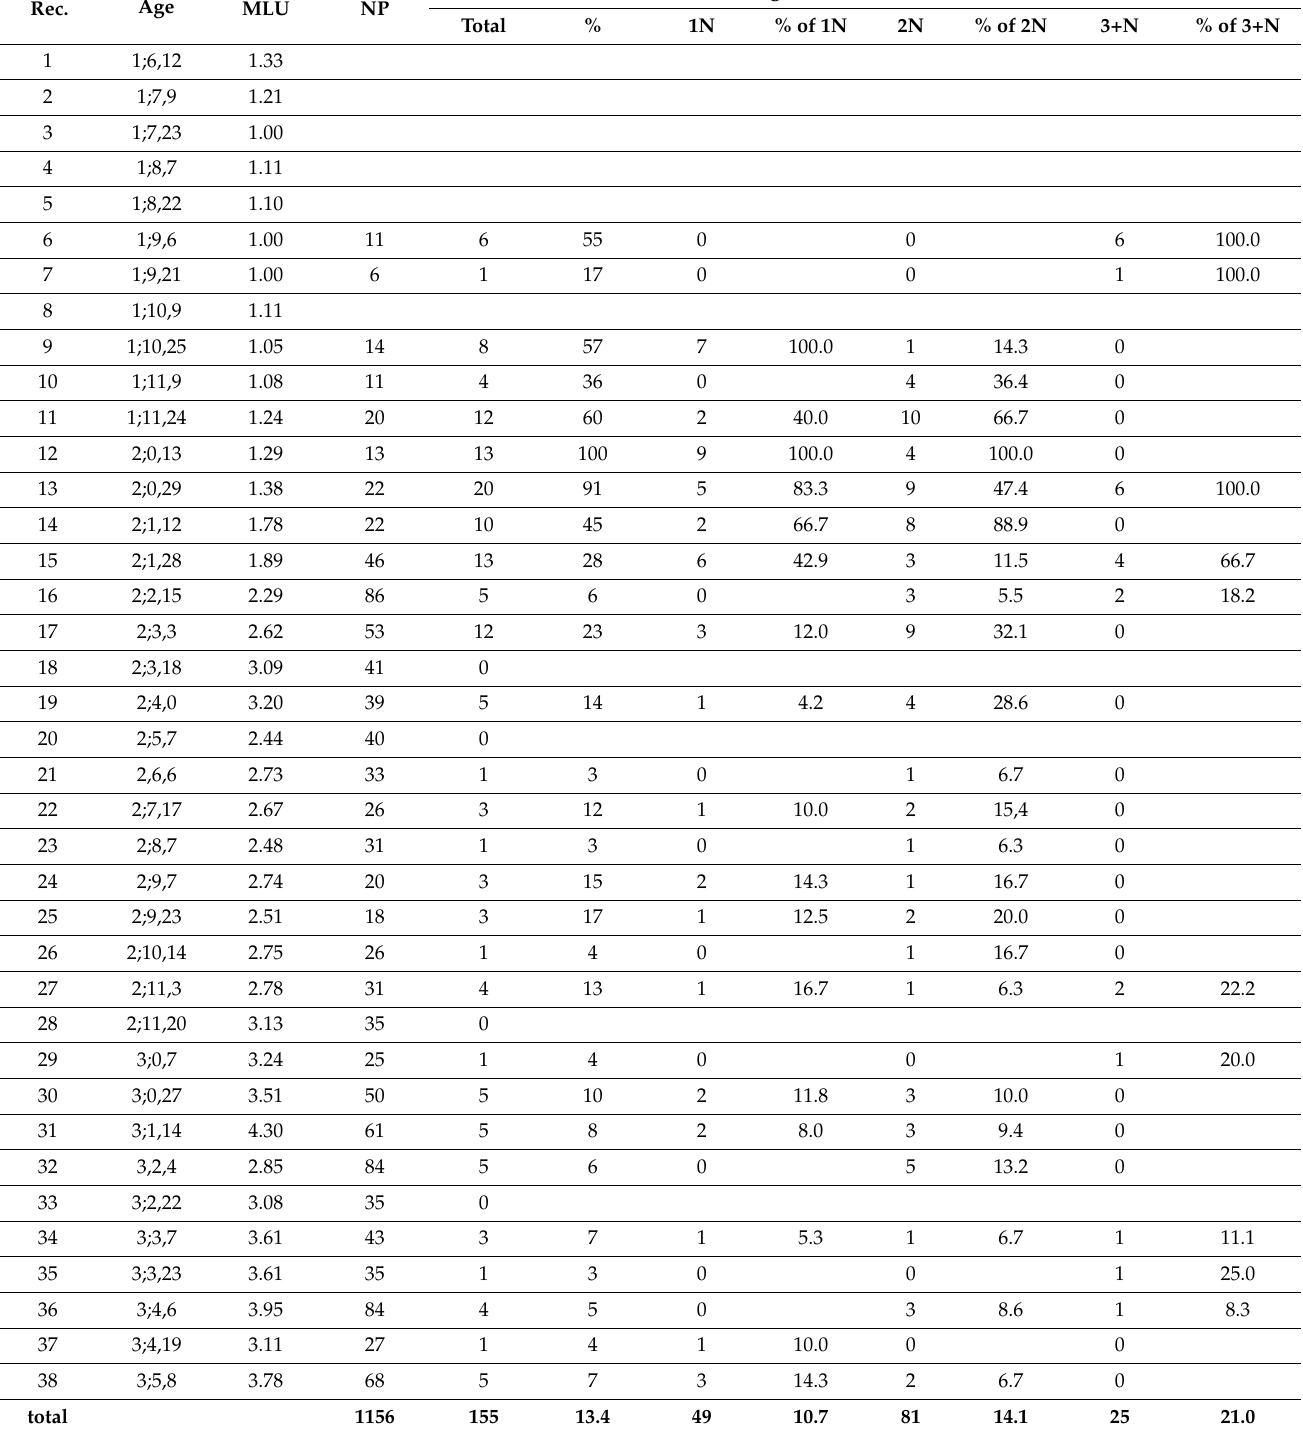
Table A2. Si_fi: Target-deviant bare nouns per